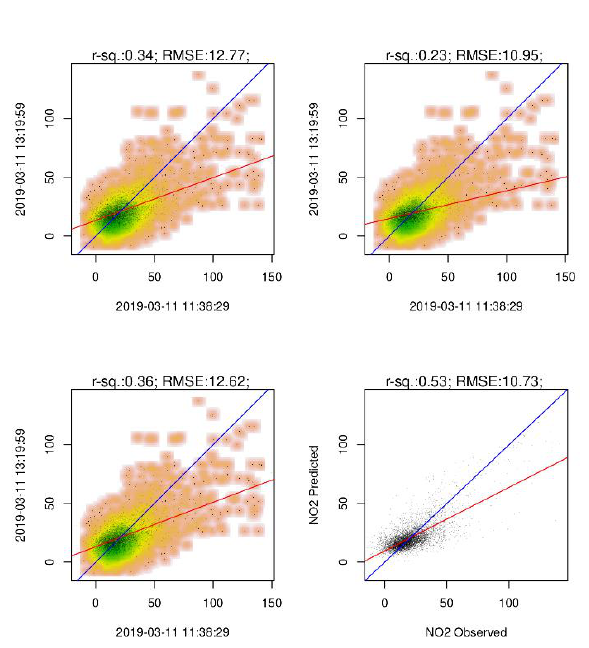
Figure 7. An example with a lower coefficient of determination and lower values of NO2 concentration. The figure structure is the same as described in Figure 6.